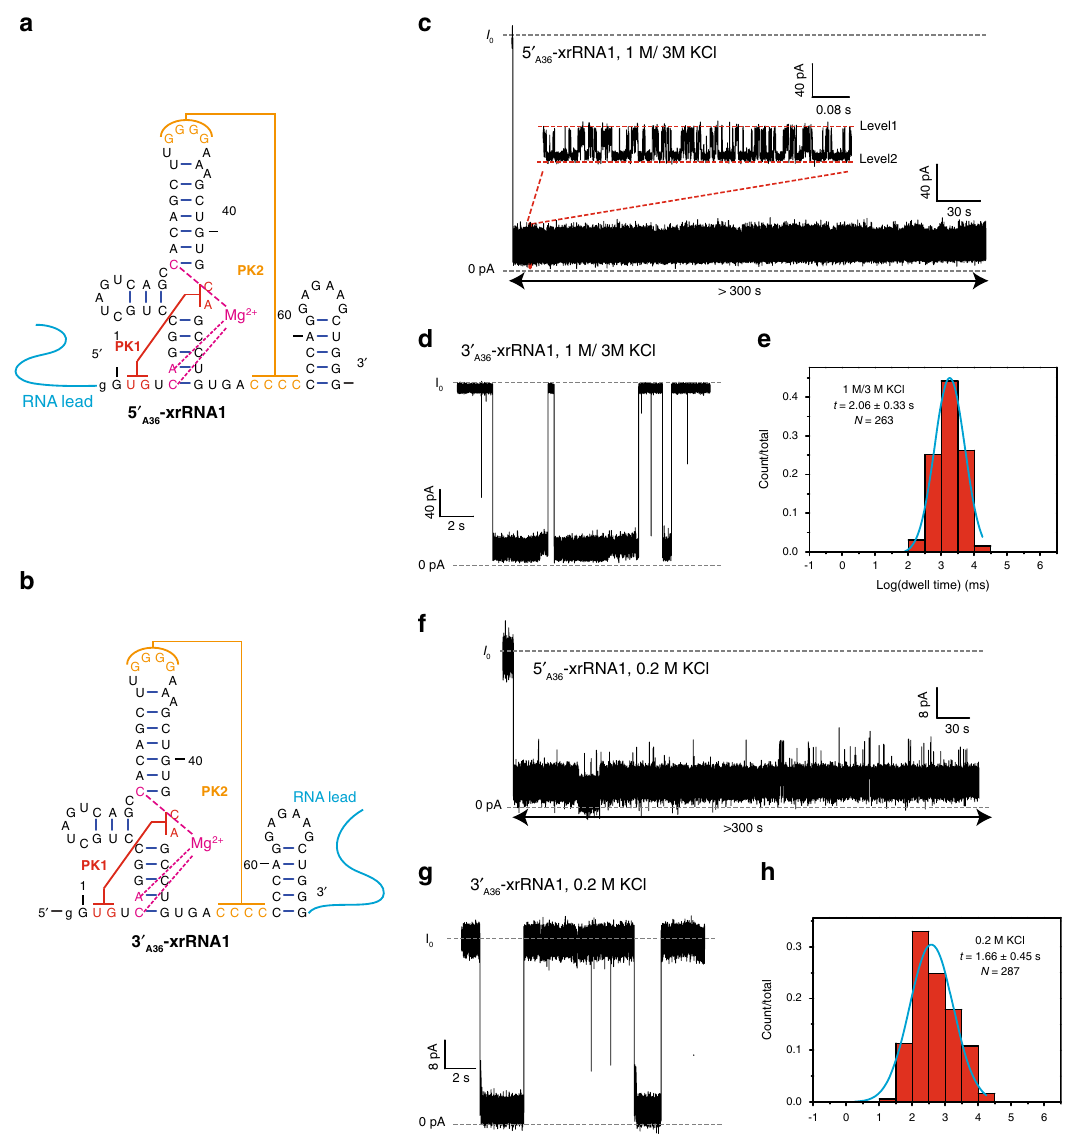
Fig. 2 ZIKV xrRNA1 exhibits signi fi cant mechanical anisotropy in the presence of 5 mM Mg 2 + . a , b Secondary structure of 5 ′ A36 -xrRNA1 ( a ) and 3 ′ A36 - xrRNA1 ( b ), which a 36 nt poly(A) was co-transcribed at the 5 ′ - or 3 ′ -end of the xrRNA1. c , d , f , g Representative current blockade traces for unfolding of 5 ′ A36 -xrRNA1 in 1 M/3 M KCl ( c ) and 0.2 M KCl ( f ), 3 ′ A36 -xrRNA1 in 1 M/3 M KCl ( d ), and 0.2 M KCl ( g ) in the α -hemolysin nanopore. e , h Dwell time distribution histograms for the unfolding of 3 ′ A36 -xrRNA1 in 1 M ( cis )/3 M ( trans ) KCl solutions ( e ) and 0.2 M KCl solution ( h ). The dwell time were presented as the mean ± SEM, which is calculated from N > 200 events and 3 independent repeat